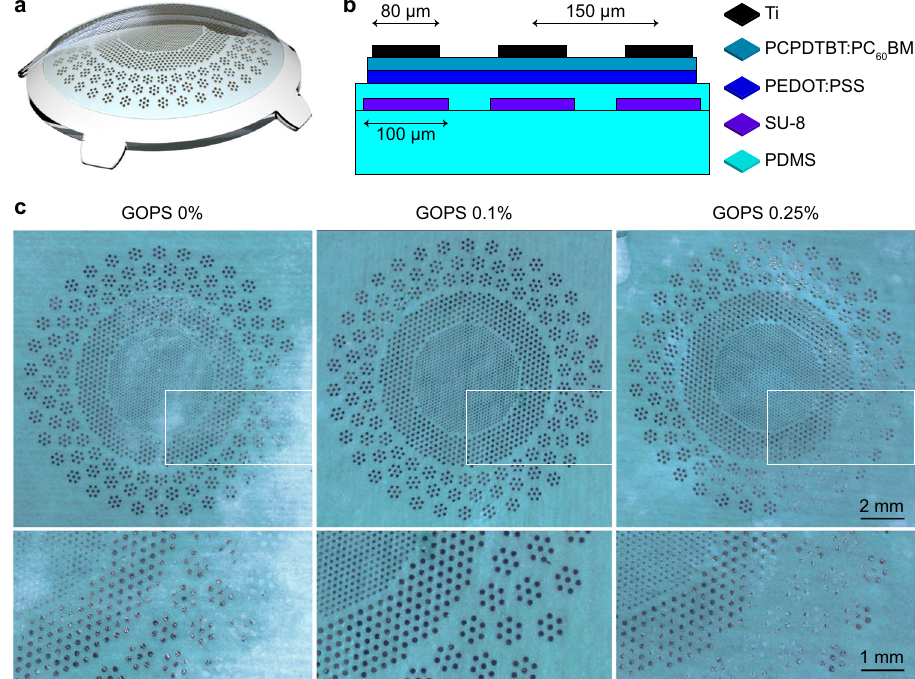
Fig. 6 Adhesion of the interface. a 3D model of the nirPOLYRETINA prosthesis. b Cross-section of the nirPOLYRETINA active interface, including: PDMS (50 µ m), a second layer of PDMS (14 µ m) embedding SU-8 rigid platforms (6 µ m), a layer of PEDOT:PSS with various percentages of GOPS, a layer of PCPDTBT:PC 60 BM (100 nm), and titanium cathodes (150 nm). c Pictures of nirPOLYRETINA devices prepared with 0, 0.1 and 0.25 v/v% of GOPS after soaking in saline solution and ultra-sonication for 5